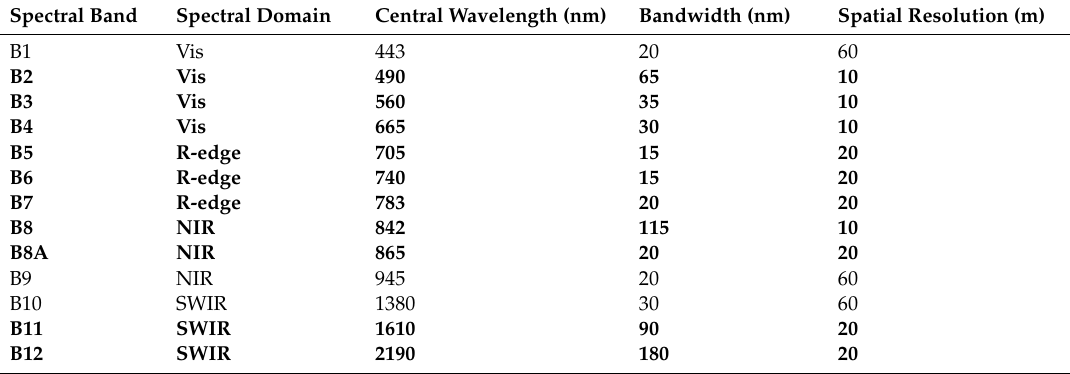
Table 1. Specifications of a Sentinel-2 MultiSpectral Instrument sensor (in bold characters, bands provided by the Muscate platform used in this work).